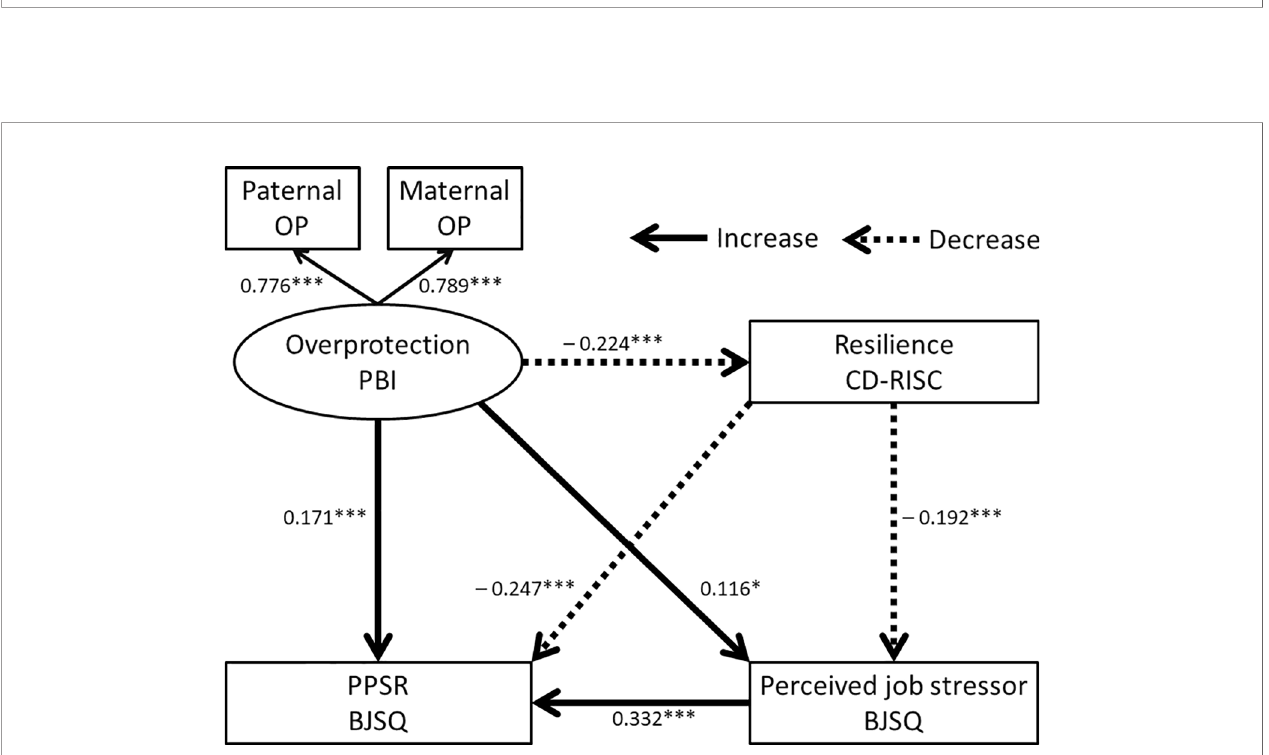
FIGURE 2 | Structural equation model of parental overprotection (PBI), resilience (CD-RISC), perceived job stressors (BJSQ), and PPSR (BJSQ). Solid arrows indicate increased effects and dotted arrows indicate decreased effects. Coef fi cients beside the lines are standardized. The latent variable “ overprotection ” consists of both paternal and maternal overprotection (OP). PBI, Parental Bonding Instrument; CD-RISC, Connor-Davidson Resilience Scale; BJSQ, Brief Job Stress Questionnaire. *p < 0.05, ***p < 0.001.